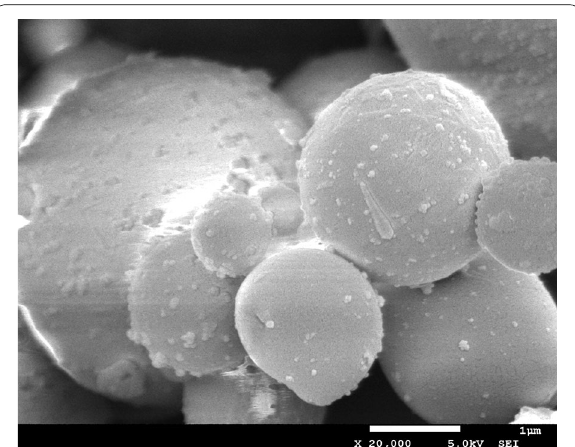
Fig. 1 SEM images of fly ash.